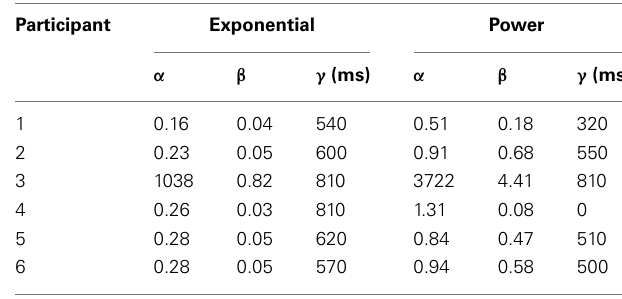
Table 3 | Best fitting parameter values for the three-parameter power and exponential